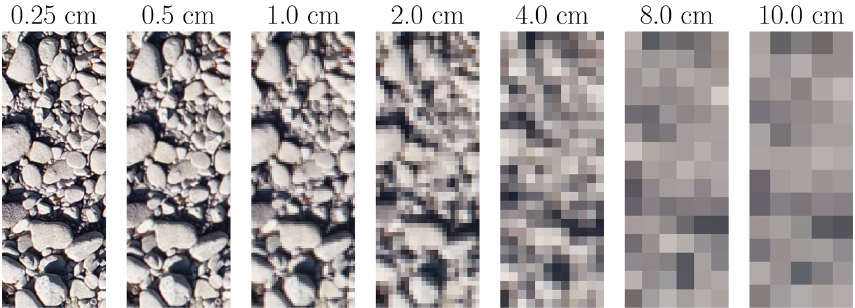
Figure 20. Example image tile resampled to lower resolutions. Left to right: full resolution of 0.25cm and tested downsampling factors: 2, 4, 8, 16, 32, and 40, corresponding to 0.5, 1.0, 2.0, 4.0, 8.0, and 10.0cm, respectively.